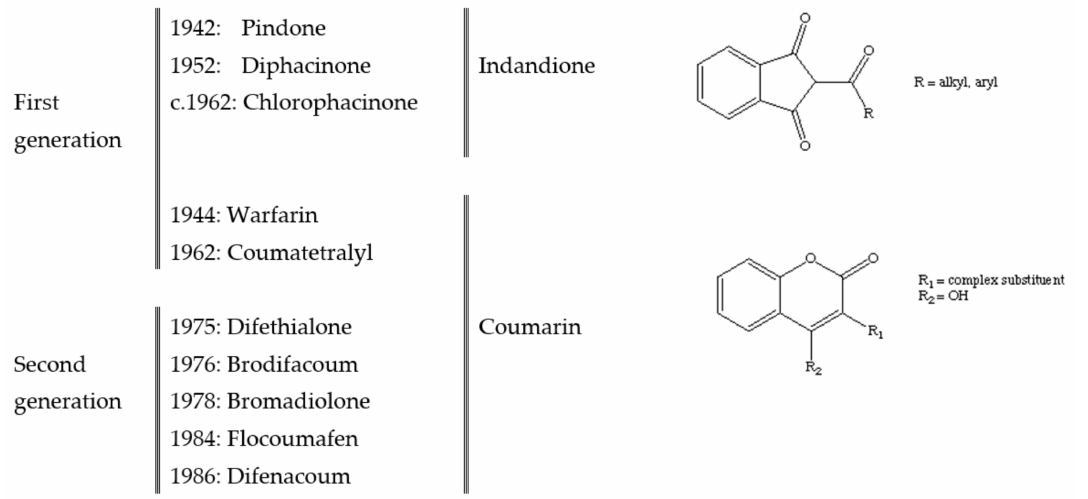
Figure 1. Date of development and use of first- and second-generation anticoagulant rodenticides, and their grouping by chemical structure [16]. c’—Circa